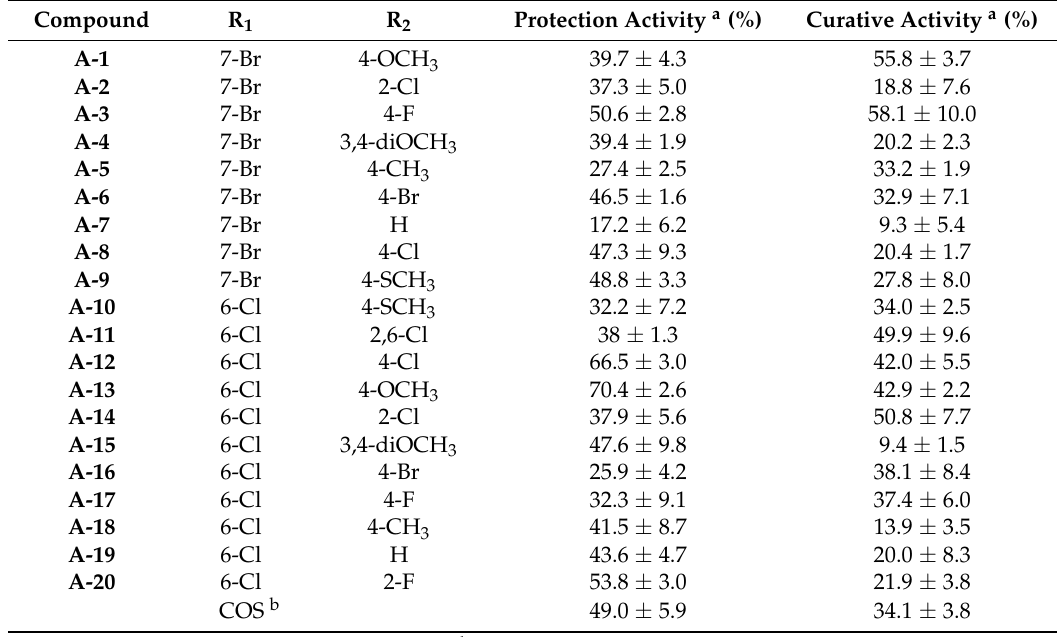
Table 1. The antiviral activities of the target compounds against TMV in